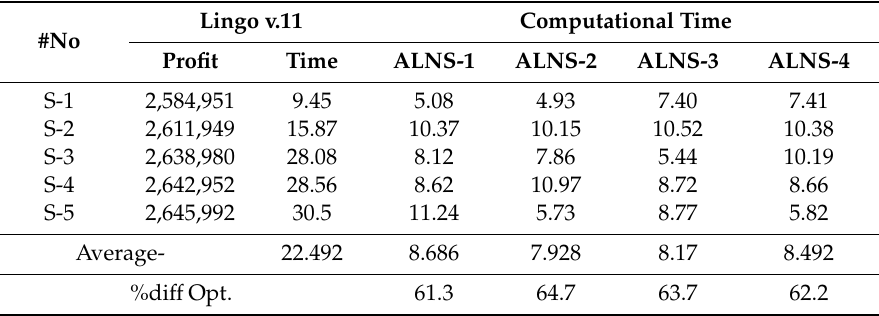
Table 9. Computational results of the test